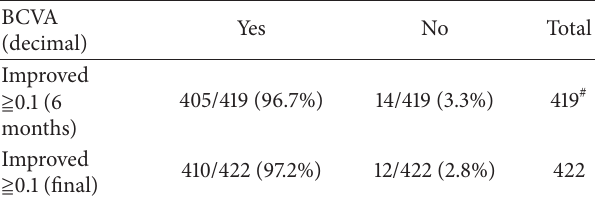
Table 2: Functional success after 6 months and at final follow-up.